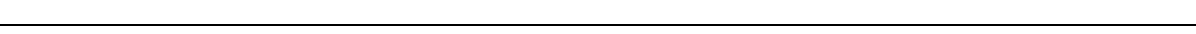
Fig. 1 Asymmetric RHOA activity correlates with NC polarity and directed migration. Processed FRET signal images of delaminating a , early migrating b and late migrating NCCs c . The magni fi ed area and selected cells are marked with dotted squares. White arrowheads indicate FRET signal. Scale bars, 50 µ m. d Schematic representation of asymmetric RHOA activity in a polarized NCC. Quanti fi cation of the ratio of the FRET index between the back and front of delaminating ( n = 107), early migrating ( n = 123) and late migrating NCCs ( n = 196). 25 embryos were analyzed. Mean ± s.e.m. Student ’ s t-test, ns, not signi fi cant. e Processed FRET signal images of time-lapse series of delaminating NCCs. White arrowheads indicate RHOA activity at the cell front. Scale bar, 50 µ m. f Schematic representation of asymmetric RHOA activity in a polarized NCC undergoing directional migration. Quanti fi cation of the ratio of the FRET index between the back and front over time. n = 81 cells from 26 explants were analyzed. g Quanti fi cation of the total FRET index in the indicated region. Mean ± s.e.m.; n = 81; Student ’ s t test; *** p < 0.0001. h Heat maps representing the FRET index as a function of time at the back or at the front, and the FRET ratio between the back and front of 12 selected NCCs from 12 explants. i Processed FRET signal images of time-lapse series of a migrating NCC. White arrows indicate the change of migratory direction toward SDF-1. Scale bar, 50 µ m. j Schematic representation of RHOA activity distribution in a polarized NCC undergoing directional change of movement toward SDF-1 coated beads. k Quanti fi cation of the ratio of the FRET index between the back and front of migratory NCCs. n = 81 cells from 21 explants were analyzed. l Example of a stationary NCC undergoing front and back switch in response to SDF-1. n = 72 from 17 explants were analyzed. White arrowheads indicate initial accumulation of high RHOA activity in the cell front. White arrows indicate direction of cell repolarization. Scale bar, 50 µ m. m Schematic representation of the example shown in Fig. 1l. n Quanti fi cation of the ratio of the FRET index between A and B of the example shown in Fig. 1l. Mean ±